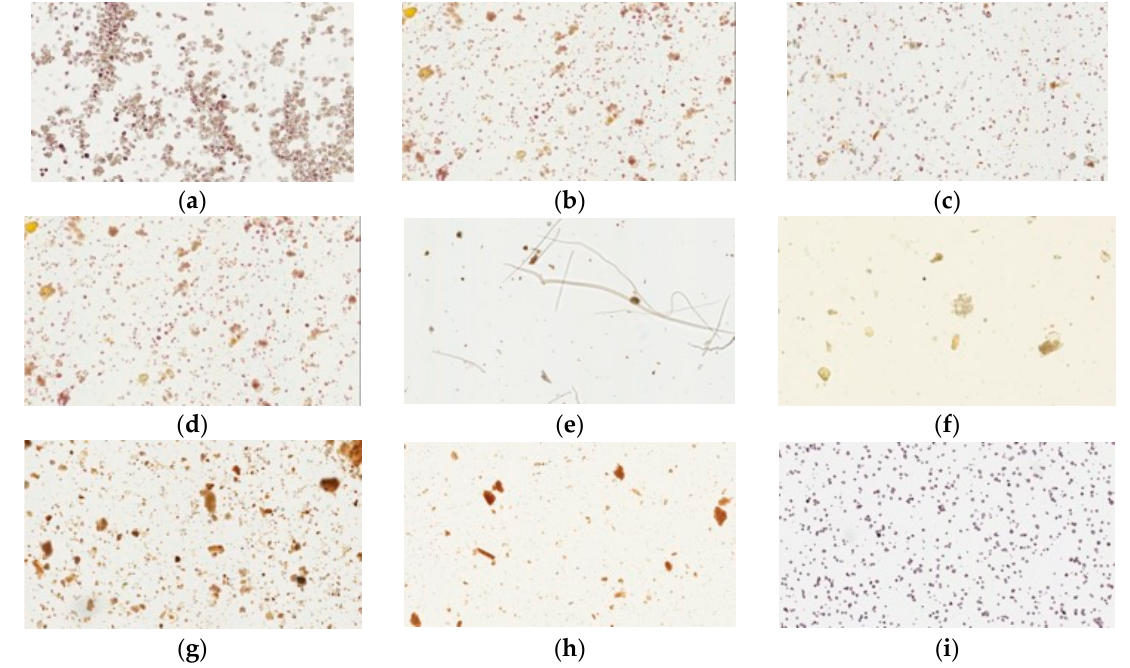
Figure 4. Light microscopy photographs of iodine staining of Yin-Chen-Hao-Tang in preparations of pharmaceutical products ( a – d ) products from brand A–D; raw herbal powders: ( e ) Artemisia capillaries Thunb; ( f ) Gardenia jasminoides Ellis; ( g ) Rheum officinale Baill; ( h ) Yin-Chen-Hao-Tang decoction; and ( i ) cornstarch.